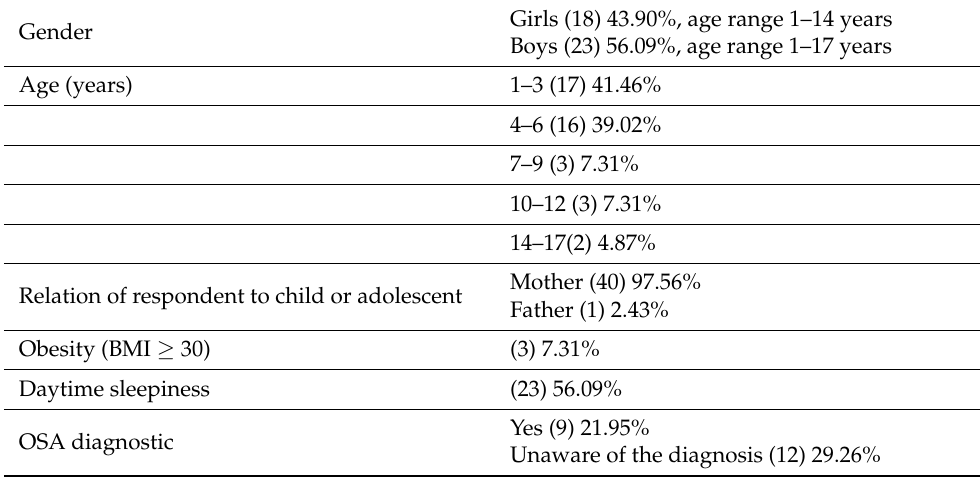
Table 1. DS child and adolescent